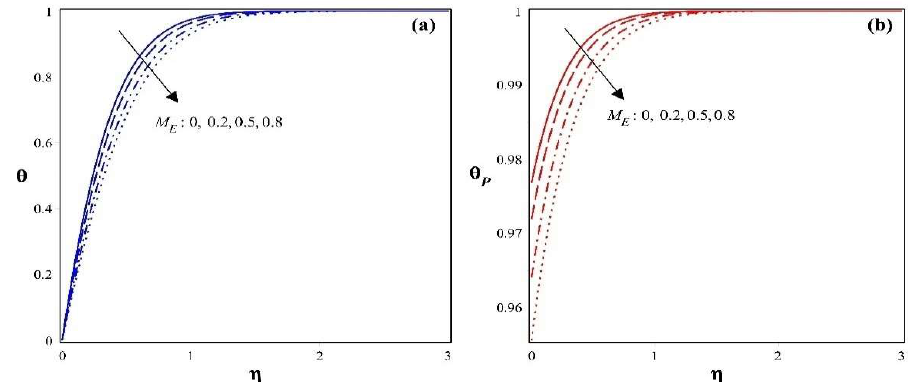
Figure 5. ( a ): Effect of the Eckert number on the fluid-phase temperature profile and ( b ):effect of the Eckert number on the dust-phase temperature profile.